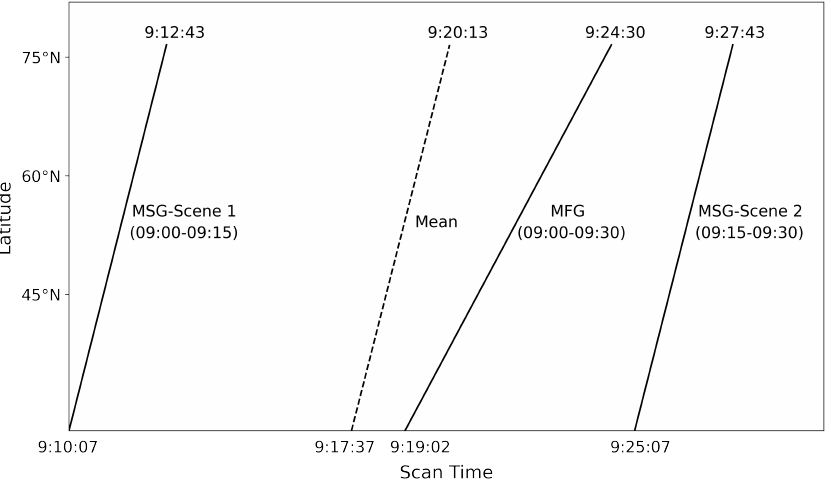
Figure 5. Plot depicting the scan times of one MFG slot (e.g., 09:00–09:30) and the two enveloping MSG scenes (e.g., 09:00–09:15, 09:15–09:30) along the latitudinal gradient of our study area. The dashed line represents the arithmetic mean of the two MSG scan times which is not fitting the MFG time. To better reproduce the temporal coverage of MFG with the two MSG scenes, we introduced weighted averaging (Equations (5)–(7)).